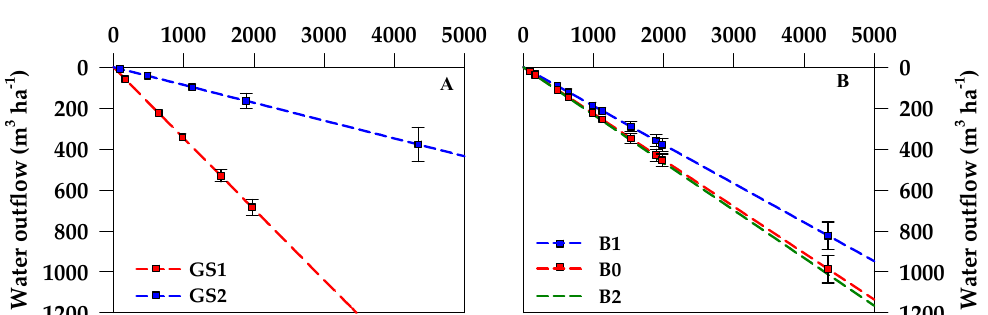
Figure 4. Set of linear regressions as result of the ANCOVA drainage model. ( A ) average effect of the growing seasons GS1 and GS2; ( B ) average effect of the biochar treatments (B0, B1, and B2). The slope of the regression lines detects the fraction of water drained with respect to the water supplied. To avoid overlapping, some symbols may be not represented.